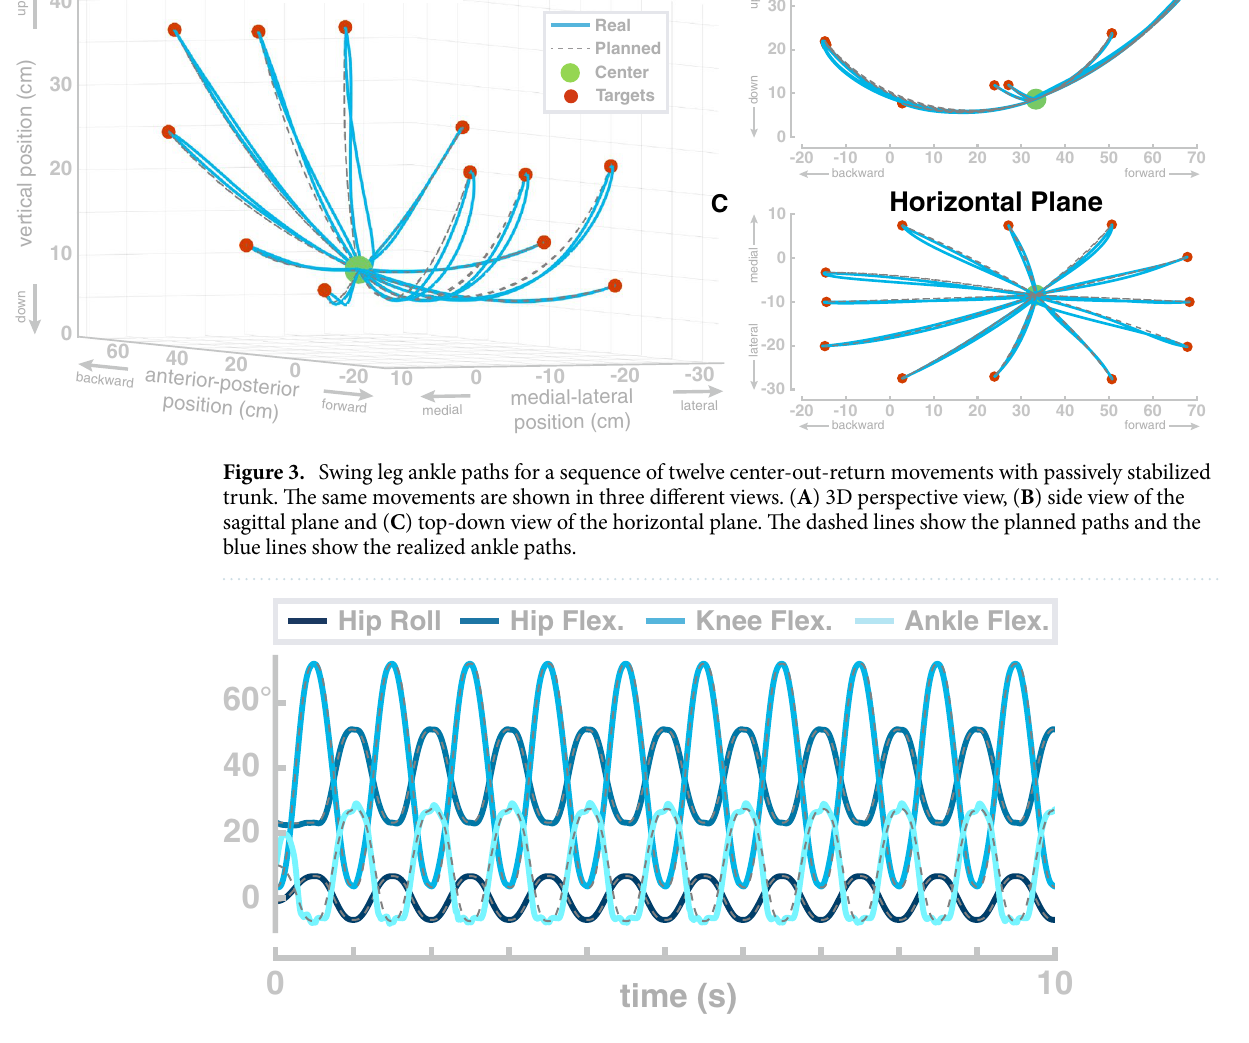
Figure 4. Example movement trajectories of the swing leg with a passively stabilized trunk. The dashed black lines show the planned movement trajectory and the blue lines show the realized joint angle trajectories.